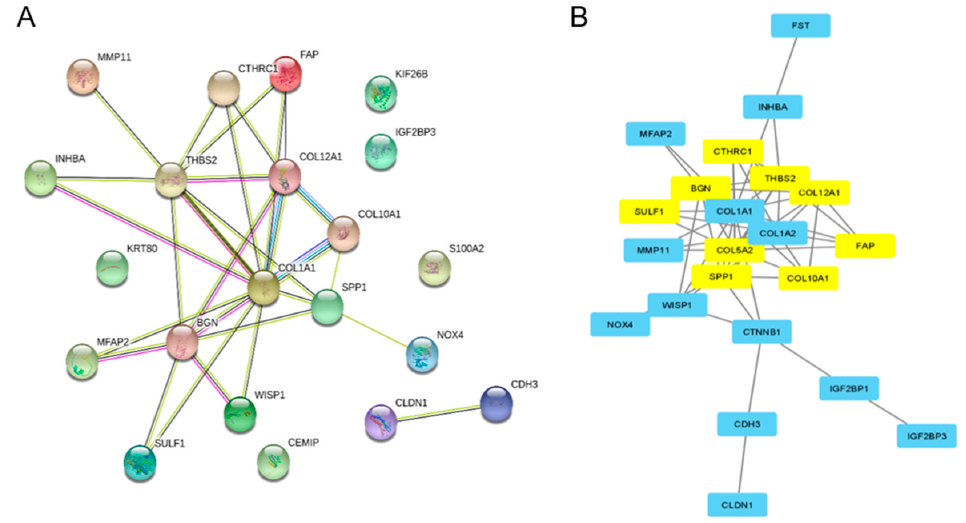
Figure 3. Protein–protein interaction (PPI) analysis. ( A ) PPI networks of the common upregulated DEGs. ( B ) Identification of nine hub genes according to MCODE score. Table 2. Hub genes selected by Cytoscape MCODE score and their biological